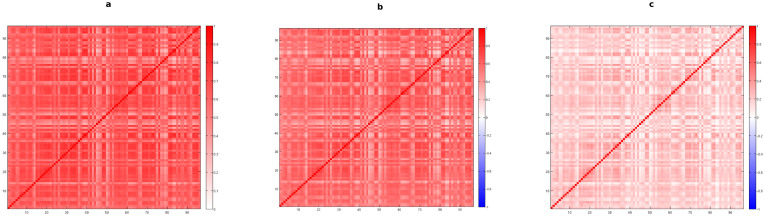
Analysis of the binary multiplexity between layers of the International Trade Network in 2011.Colorcoded matrices with entries given by mbin (a), μRG (b) and μBCM (c) for any pair of layers (commodities).